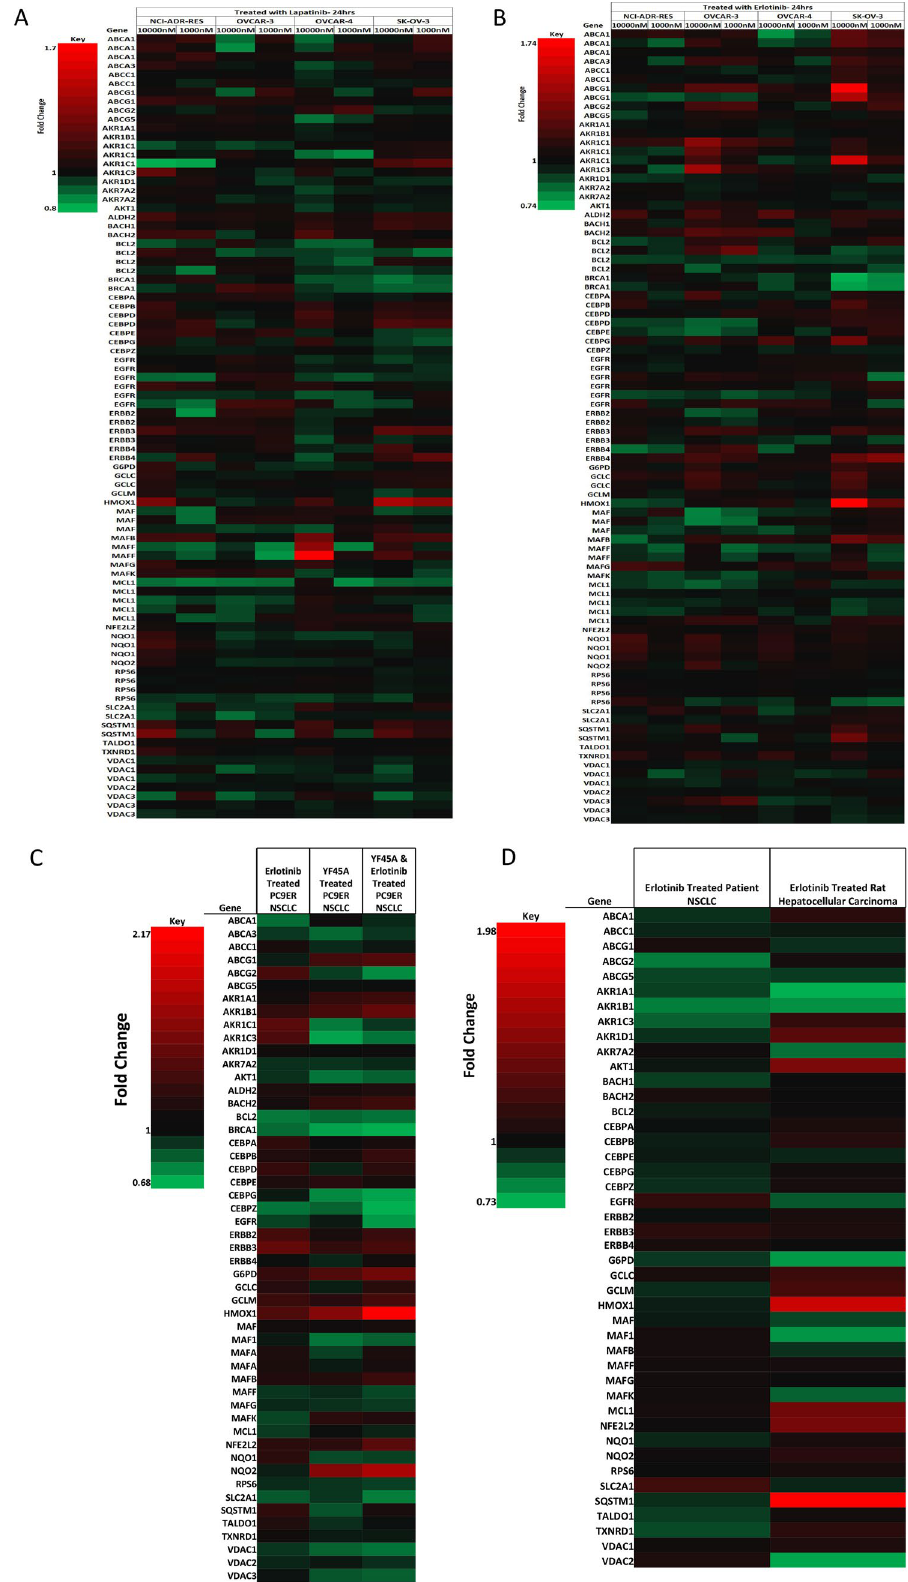
Figure 4. NRF2 network dependent molecular responses to LAP or ERL. Heatmap showing fold-change differential expression of genes within the NRF2 network relative to control treatment of a panel of ovarian cancer cells (NCI-ADR-RES, OVCAR3, OVCAR4, and SKOV3) treated for 24 h with (A) LAP (1 µM and 10 µM); (B) ERL [1 µM and 10 µM, significance analysis of microarrays (SAM) false discovery rate (FDR) = 10%] [43]; (C) heatmap showing fold-change differential expression of genes within the NRF2 network relative to control treatment of non-small cell lung cancer (NSCLC) cell lines (PC9ER) treated for 12 h with ERL (5 µM) or YF45A (0.2 µM) alone, or combination of ERL and YF45A (SAM FDR = 10%) [44]; (D) heatmap showing fold- change differential expression of genes within the NRF2 network relative to control treatment of in vivo NSCLC patients and rat hepatocellular carcinoma xenograft tumor with ERL (SAM FDR = 10%) [45]. Red represents increased expression and green decreased expression relative to the median of the